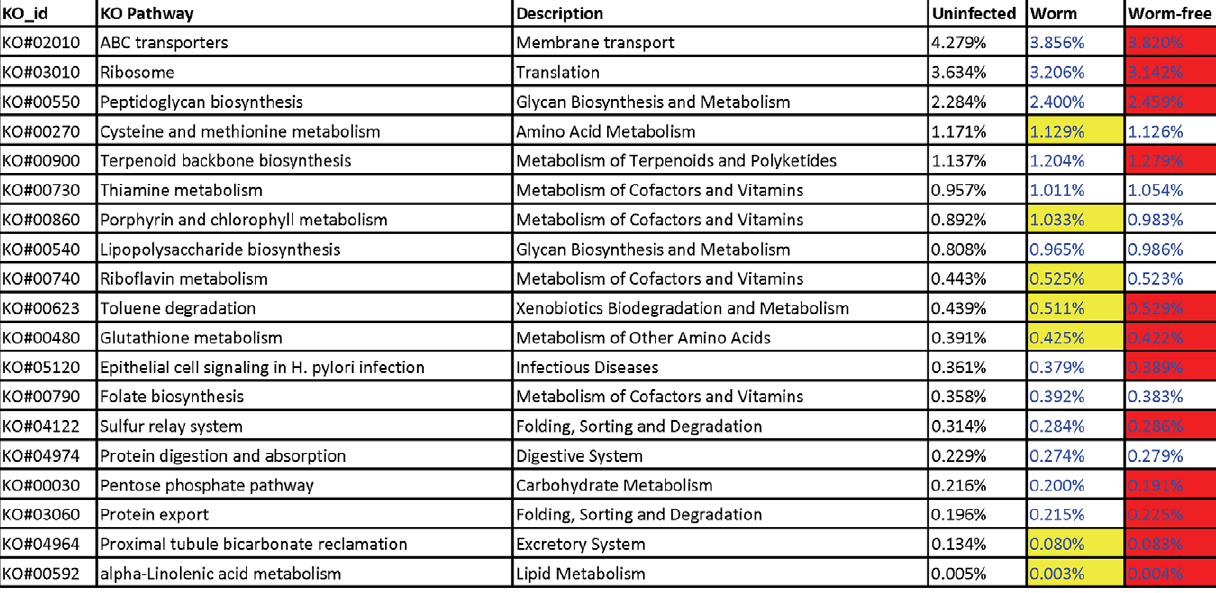
Figure 6. Select pathways were significantly affected infection with Trichurissuis in the porcine proximal colon microbiota. Numbers denote the percentage of hits positively assigned to each pathway. Different colors (Red or Yellow) indicate a significant difference between the cohorts infected with Trichuris suis that had adults worms (Worm) and the infected cohort where adult worms had been expelled (Worm-free). The numbers with a Blue font denote significant difference in relative abundance between uninfected control and infected (Worm + Worm-free)